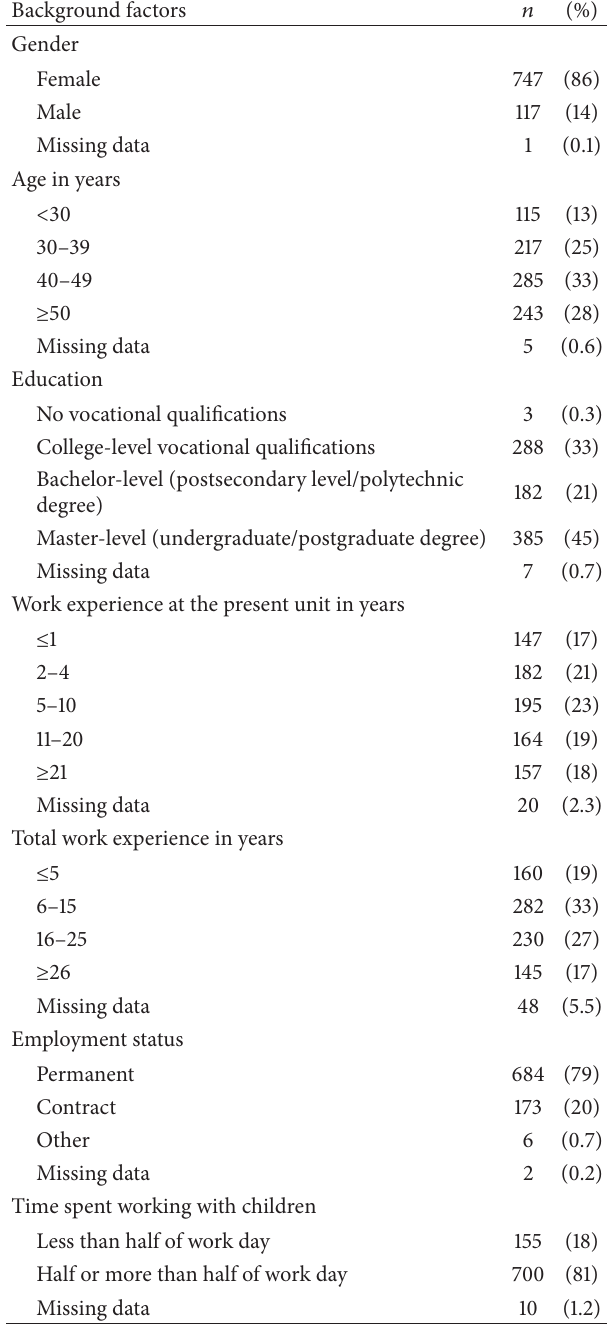
Table 2: Respondent background characteristics and job-related background factors ( 𝑛 = 865